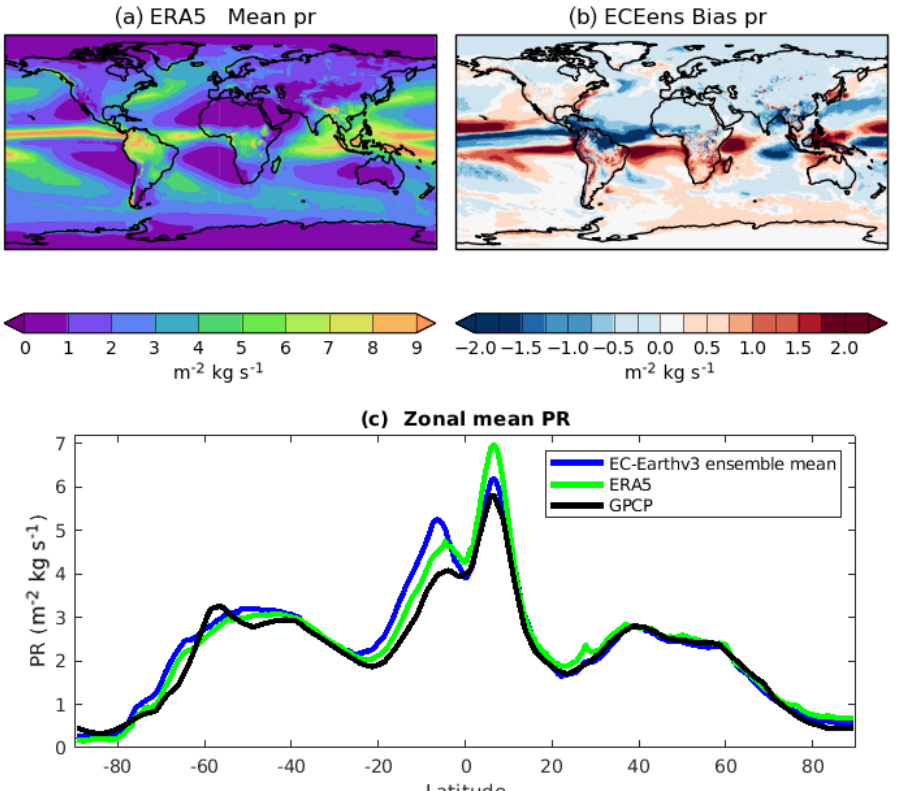
Figure 6. Mean precipitation for the period 1980–2010 for ERA5 (a) , precipitation anomaly with respect to ERA5 for EC-Earth3veg (b) , and zonal mean precipitation for ERA5 (c) (green), GPCPv2.2 (black), and EC-Earth3veg ensemble mean